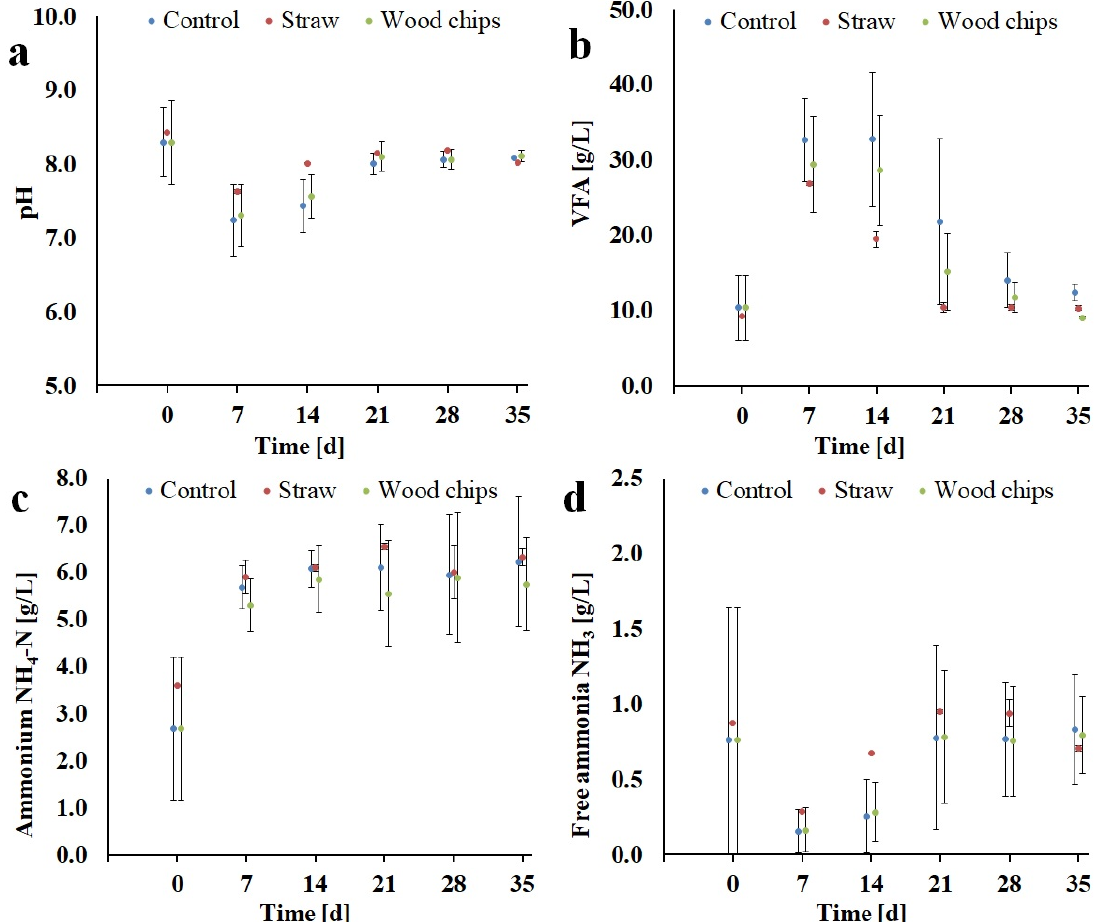
Figure 4. a–d. Process conditions during dry batch anaerobic digestion of chicken manure. pH value ( a ), volatile fatty acid concentration ( b ), ammonium concentration ( c ), free ammonia concentration ( d ).